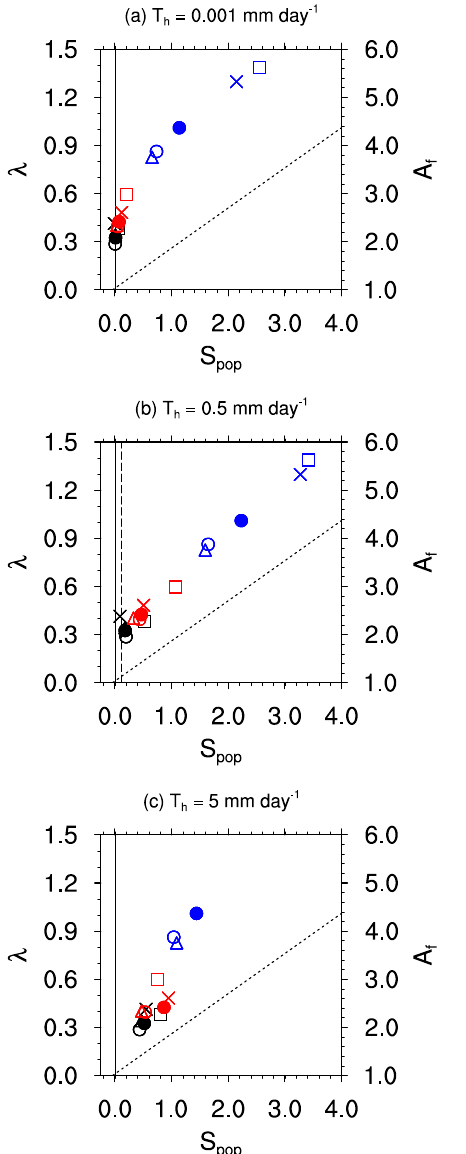
Figure 4. As in Fig. 3 except for λ vs. S pop,mod , i.e., where the denominator in Eq. (3) is N d